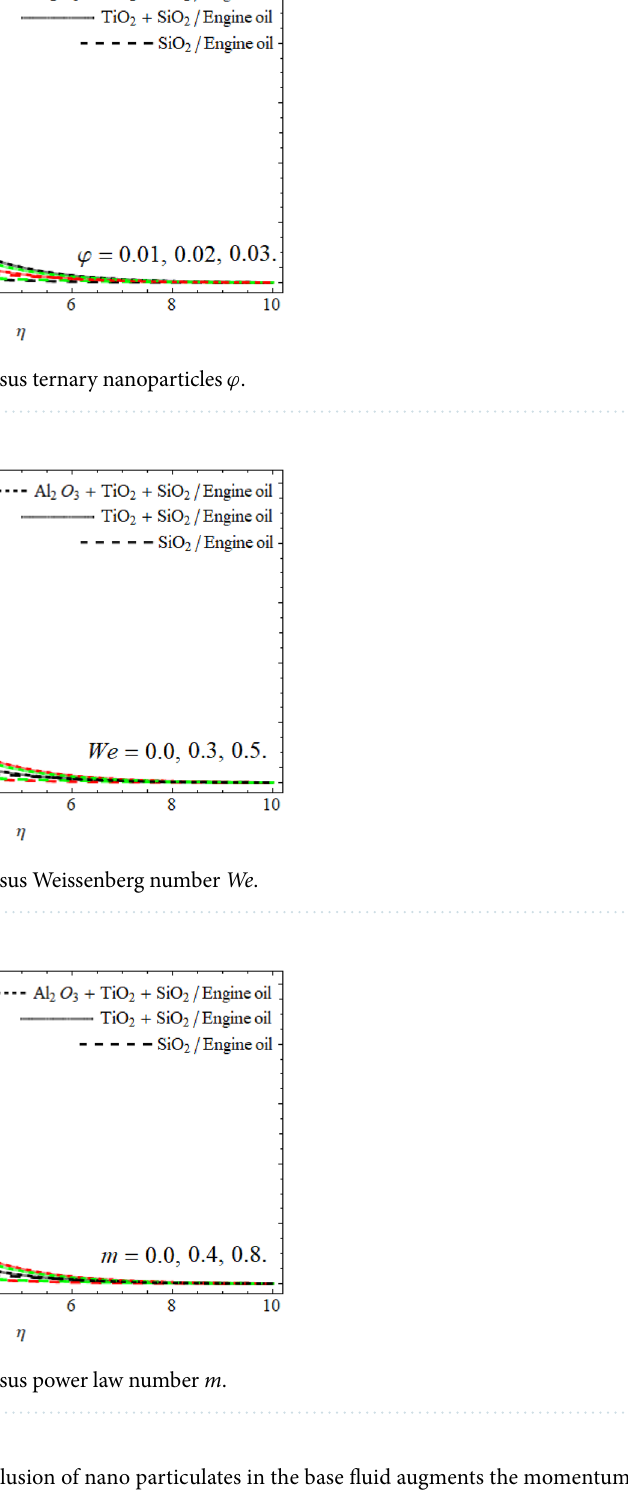
Figure 3 reported that the inclusion of nano particulates in the base fluid augments the momentum profile. The density of engine oil as compared to Al 2 O 3 , SiO 2 and TiO 2 is much higher. Therefore, the insertion of these nanoparticles into the engine oil reduces its average density, as a result, the velocity contour enhances. Figures 4 and 5 show that the velocity f ′ (η) declines with the upshot of We and power-law number m . A Weissenberg number is a physical ratio between elastic and viscous forces. It can be shown that an increase in We leads to an upsurge in the viscosity of fluid particles. As a result, the fluid becomes much thicker and reduces the number of layers of momentum boundary as elaborated in Fig. 4.